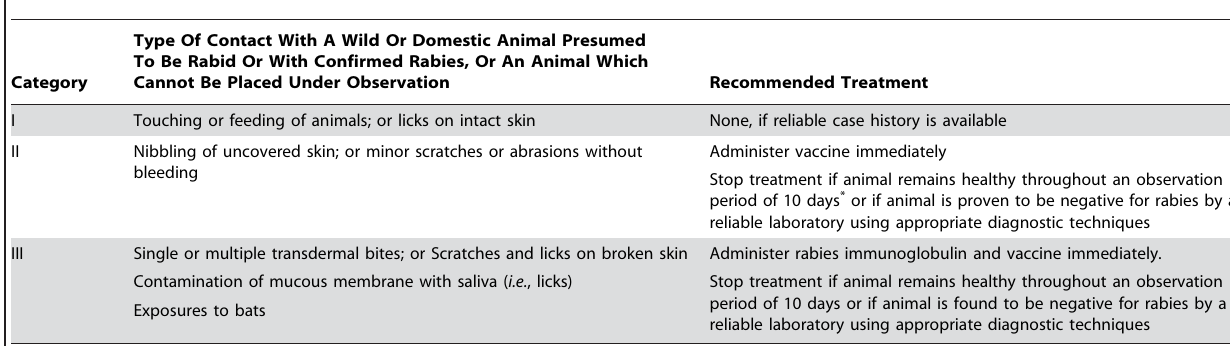
Table 1. WHO recommendations for suspected rabies post-exposure treatment [2].